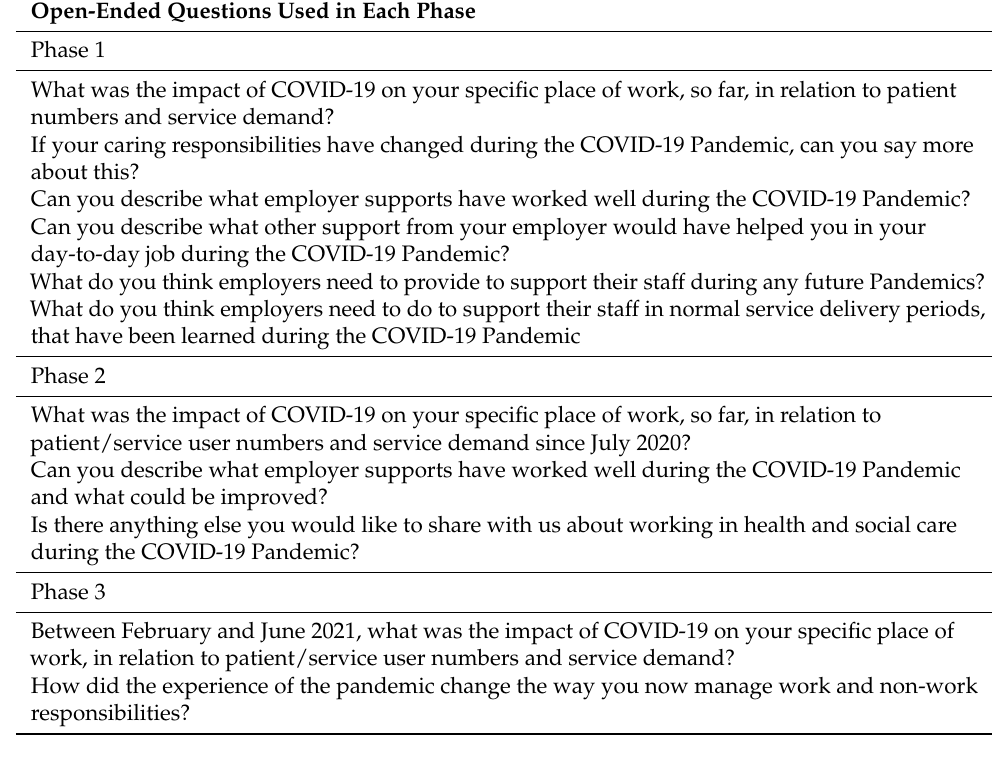
Table A1. Open-ended questions used in